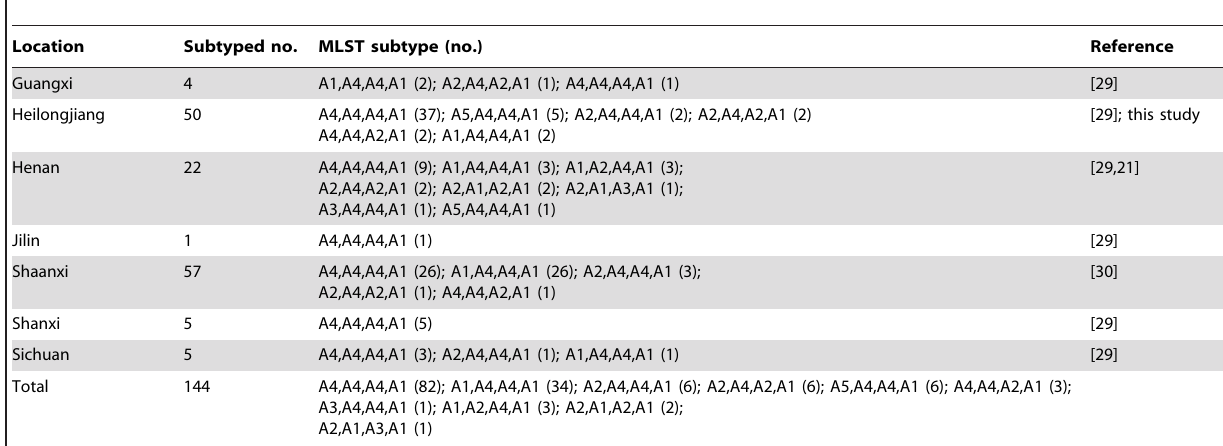
Table 4. MLST subtypes of C.andersoni in cattle in different provinces of China.